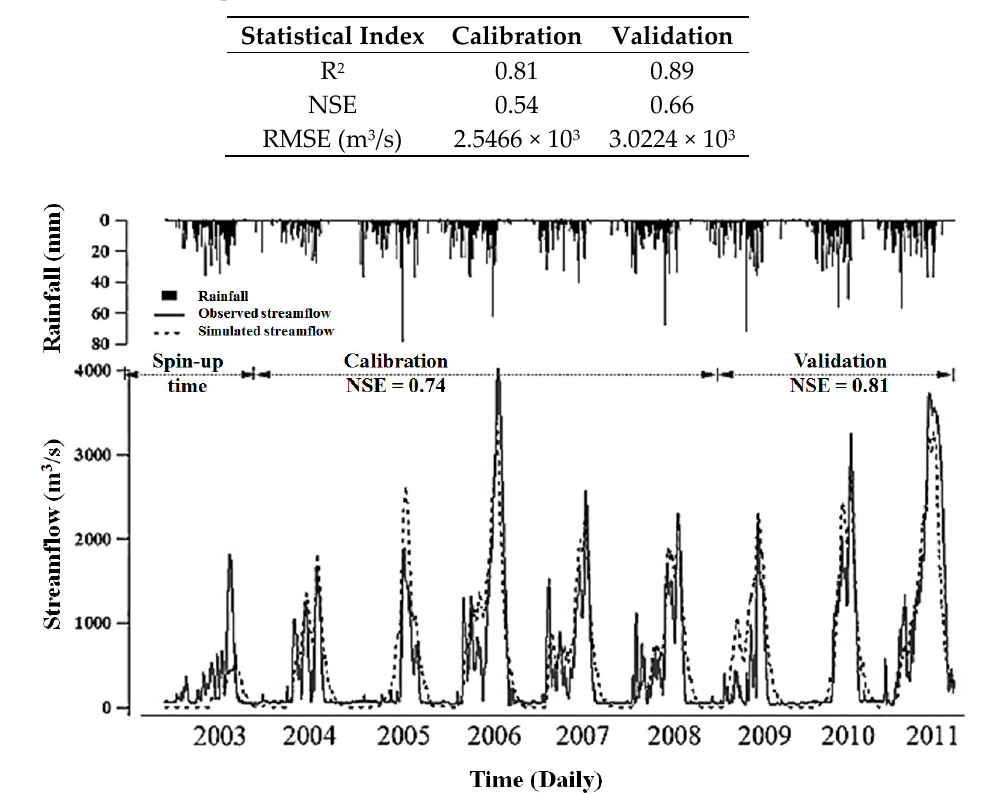
Table 6. Prediction accuracy for the monthly streamflow in terms of R 2 , Nash-Sutcliffe efficiency (NSE) and root mean square error (RMSE).